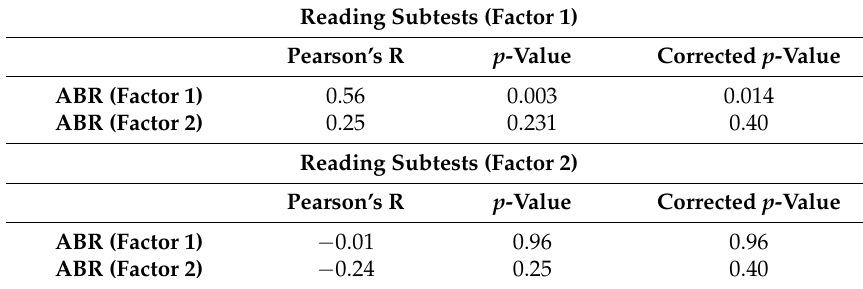
Table 9. Relations between ABR and Reading Factors. Pearson’s R computed among auditory brainstem (ABR) and reading subskills (e.g., RAN and CTOPP tests) using factors derived from PCA. Here, ABR factor 1 predominately reflected neural condition times (e.g., inter-peak latencies of the ABR waves I to III and wave I to V), while ABR factor 2 largely reflected neural response consistency. Reading factor 1 largely reflected rapid naming skills, while reading factor 2 primarily reflected phonological awareness skills. The correlations are presented with corrected probability values using the Benjamini & Hochberg (BH) correction to control the false discovery rate (FDR). Reading Subtests (Factor 1) Pearson’s R p -Value Corrected p -Value ABR (Factor 1) 0.56 0.003 0.014 ABR (Factor 2) 0.25 0.231 0.40 Reading Subtests (Factor 2) Pearson’s R p -Value Corrected p -Value ABR (Factor 1) − 0.01 0.96 0.96 ABR (Factor 2) − 0.24 0.25 0.40